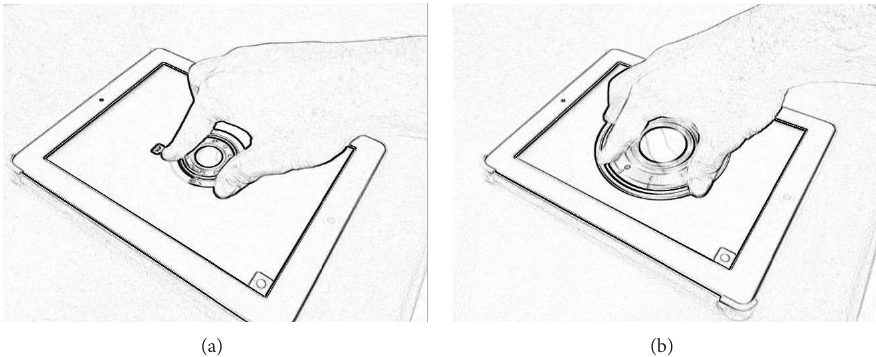
Figure 12: Example of different identities of the same